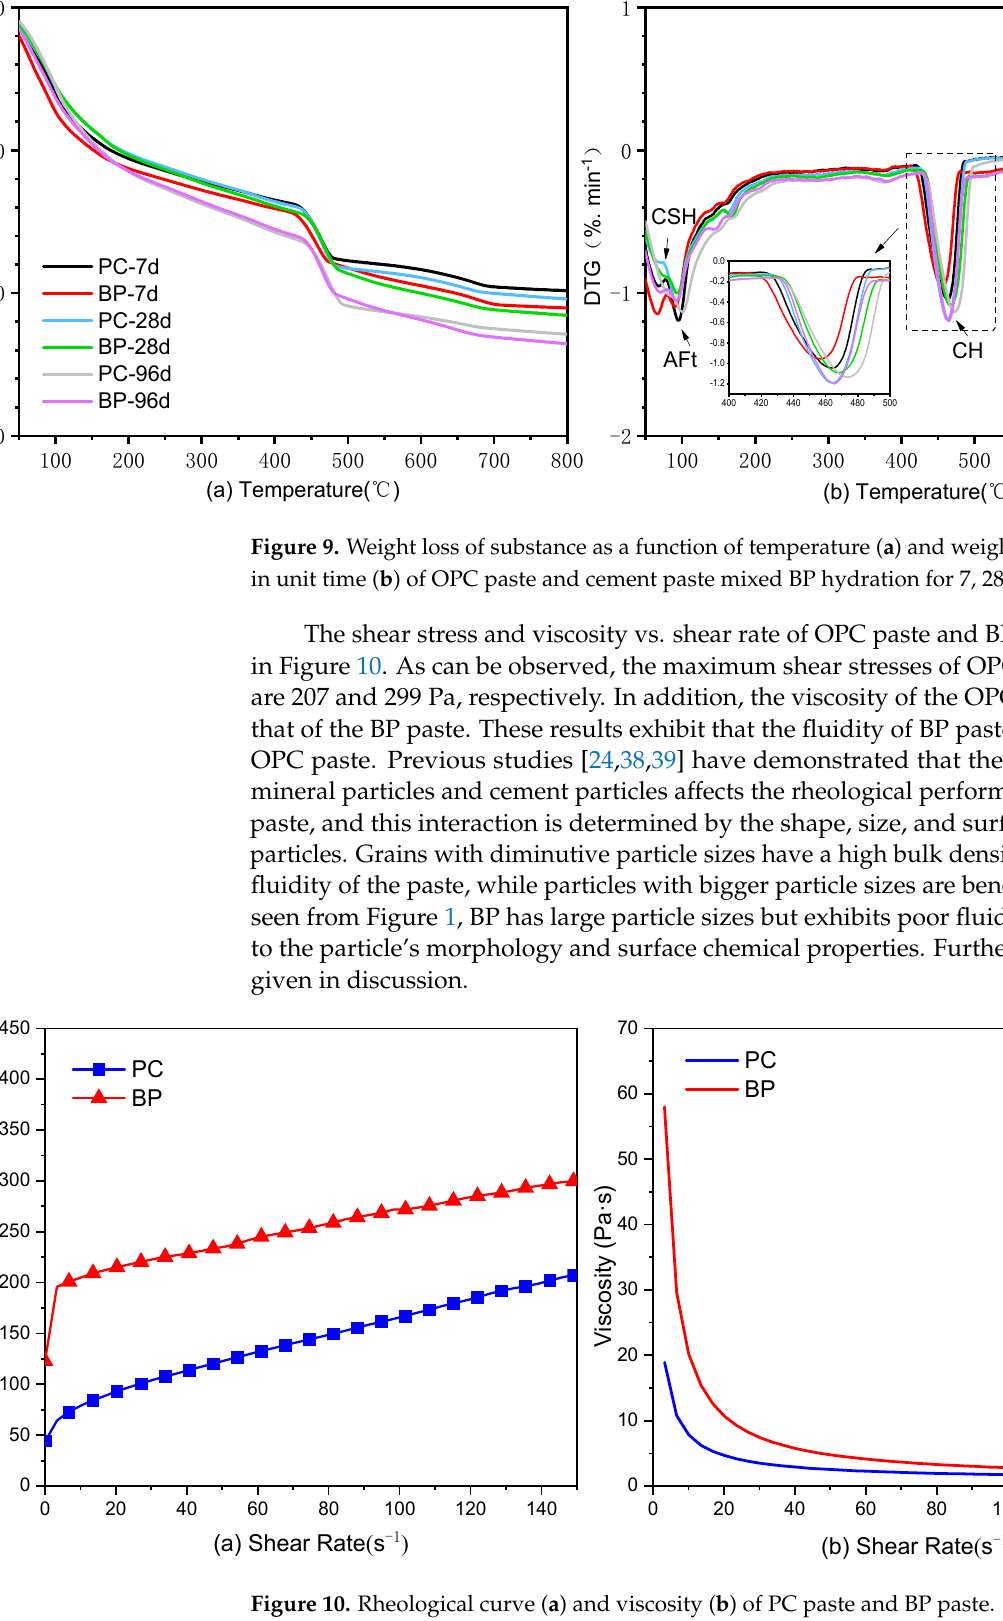
Figure 10. Rheological curve ( a ) and viscosity ( b ) of PC paste and BP paste.